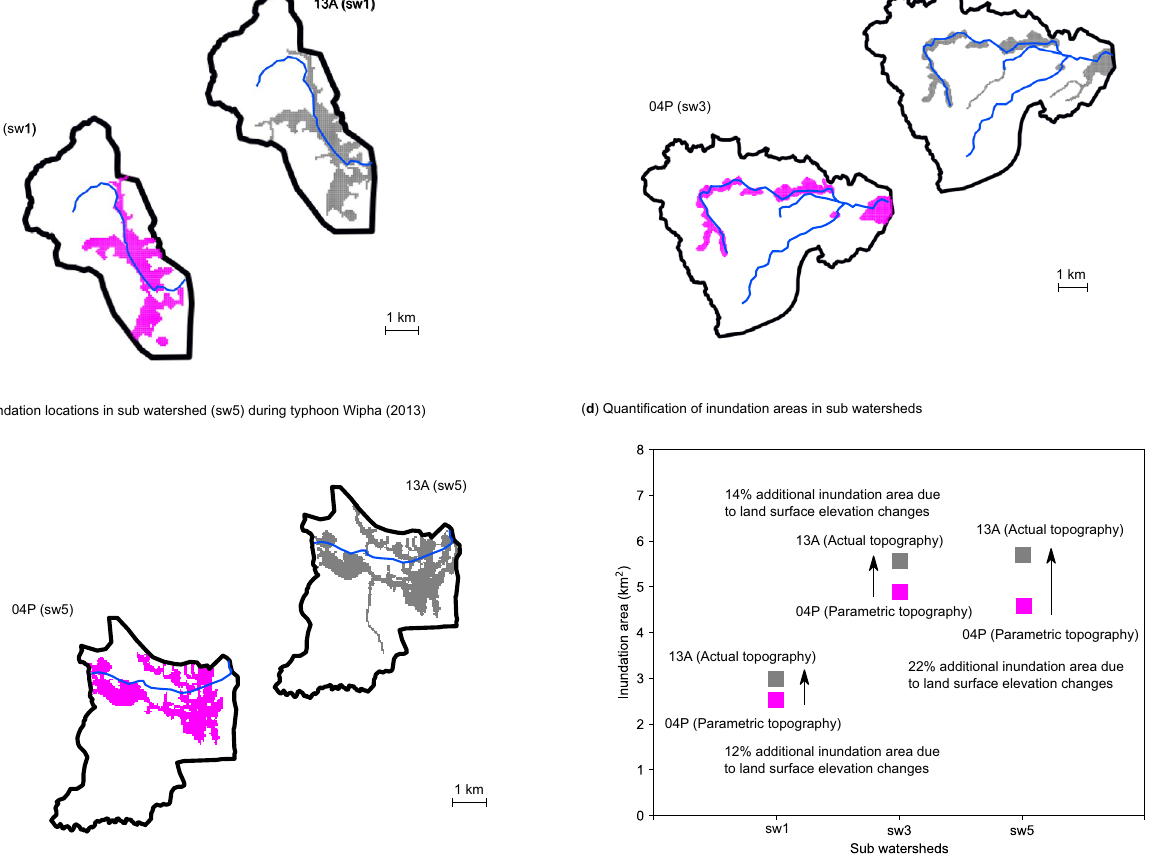
Figure 5. Detailed examination of the inundation areas in sub-watersheds during typhoon Wipha in 2013. ( a ) Inundation locations in sub-watershed 1. ( b ) Inundation locations in sub-watershed 3. ( c ) Inundation locations in sub-watershed 5. ( d ) Quantification of inundation areas in the sub-watersheds (Figure generated using Matplotlib v. 2.2.3, http://www.matpl otlib .org). Simulated inundation areas in Scenarios